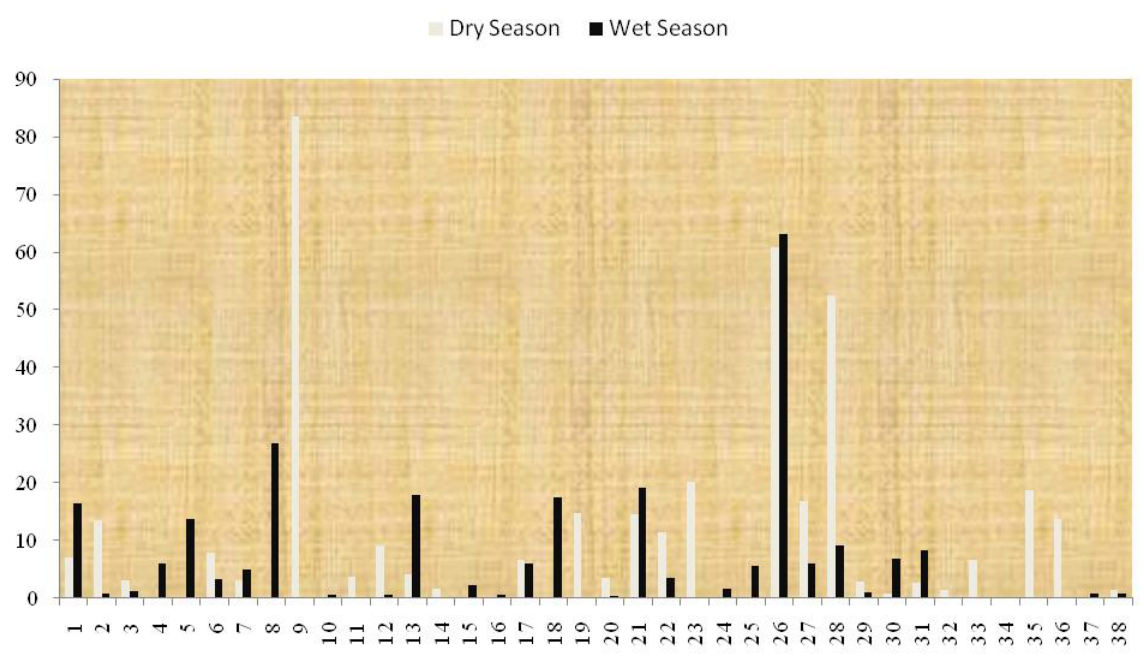
Figure 6 : Comparison of the relative abundance of C.raciborskii during wet season and the dry season in 38 reservoirs (list of reservoirs are given under Figure 2)